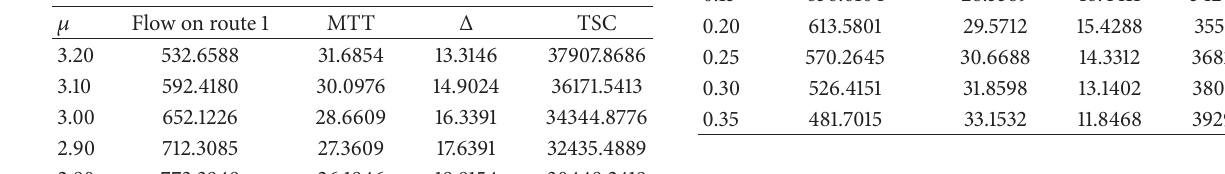
Figure 5: TSC under the scenario 2. Table 4: Results with different 𝜇 at UE.